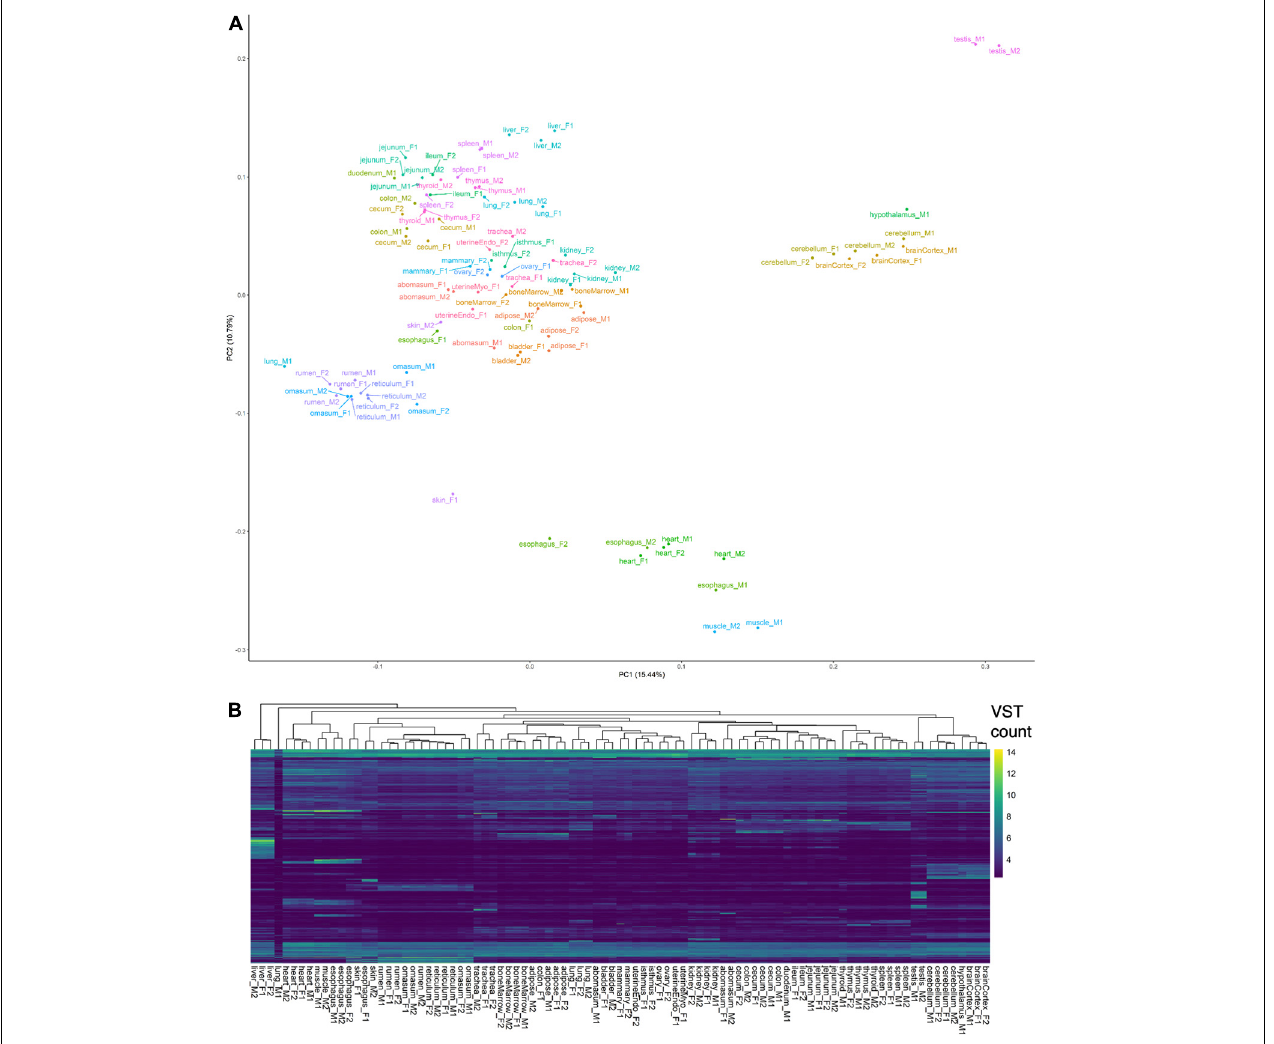
FIGURE 1 | Preliminary analysis of transcriptomes. (A) Principal components analysis of VST-normalized gene counts. (B) Hierarchical clustering of samples based on top 5,000 genes with highest variance in VST counts.